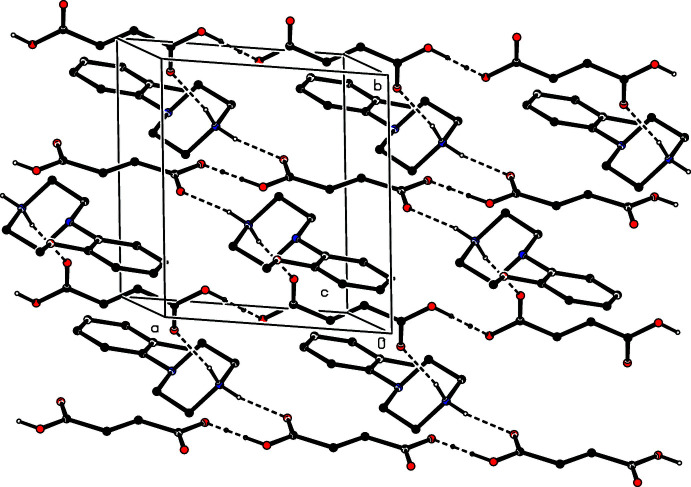
Part of the crystal structure of compound (XIV) showing the formation of a hydrogen-bonded sheet of (26) rings lying parallel to [001]. Hydrogen bonds are drawn as dashed lines and, for the sake of clarity, the H atoms bonded to C atoms have been omitted.